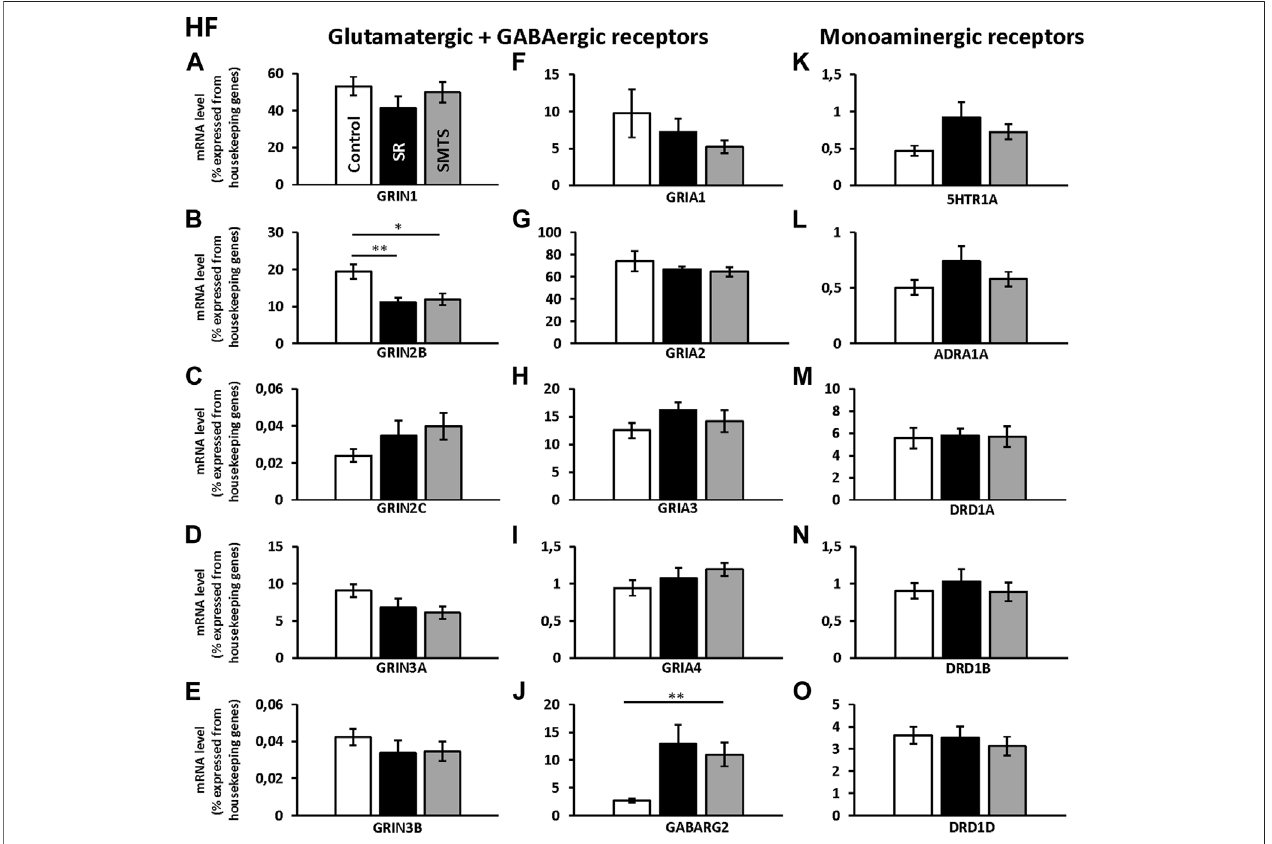
FIGURE5| NeurotransmitterreceptorexpressionintheHippocampalformation(HF)afterlearningdifferenttasks.ThemRNAlevelof15neurotransmitterreceptors and subunits were quanti fi ed as relative expression levels in percent expressed of the two housekeeping genes H3-3B and GAPDH . Results for glutamatergic and GABAergic receptor mRNA levels in the control group (Control, white), the stimulus-response group (SR, black) and the simultaneous-matching-to-sample group (SMTS, grey) are presented in (A – J) and monoaminergic receptor mRNA levels in (K – O) (mean ± SEM; Control: N = 10; SR: N = 9; SMTS: N = 8). Signi fi cant differences between the different learning groups are highlighted with asterisks ( p p < 0.03; pp p <